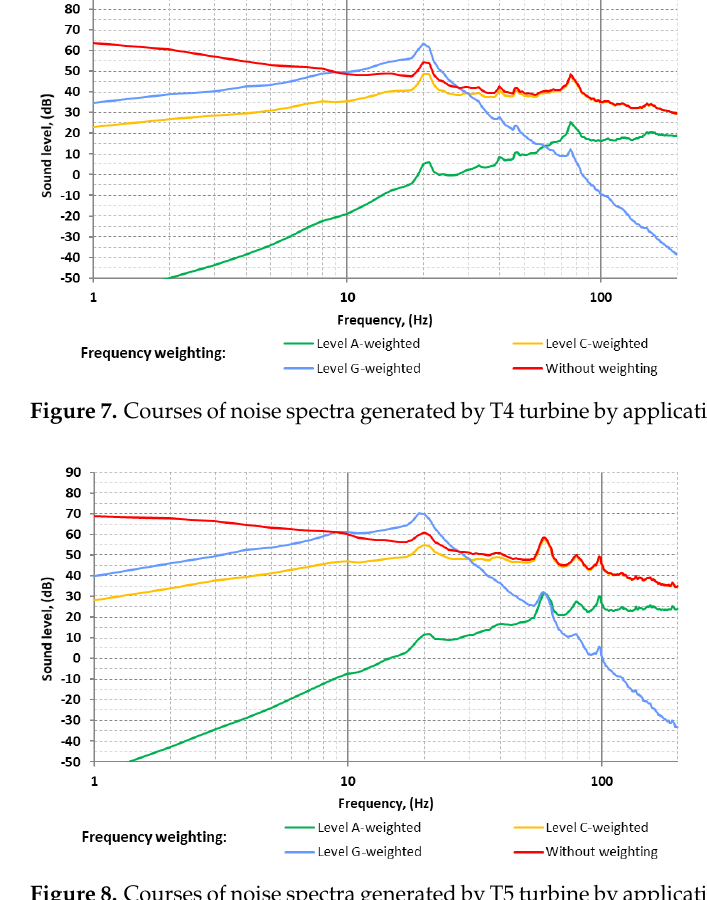
Figure 8. Courses of noise spectra generated by T5 turbine by application of various weighting curves.